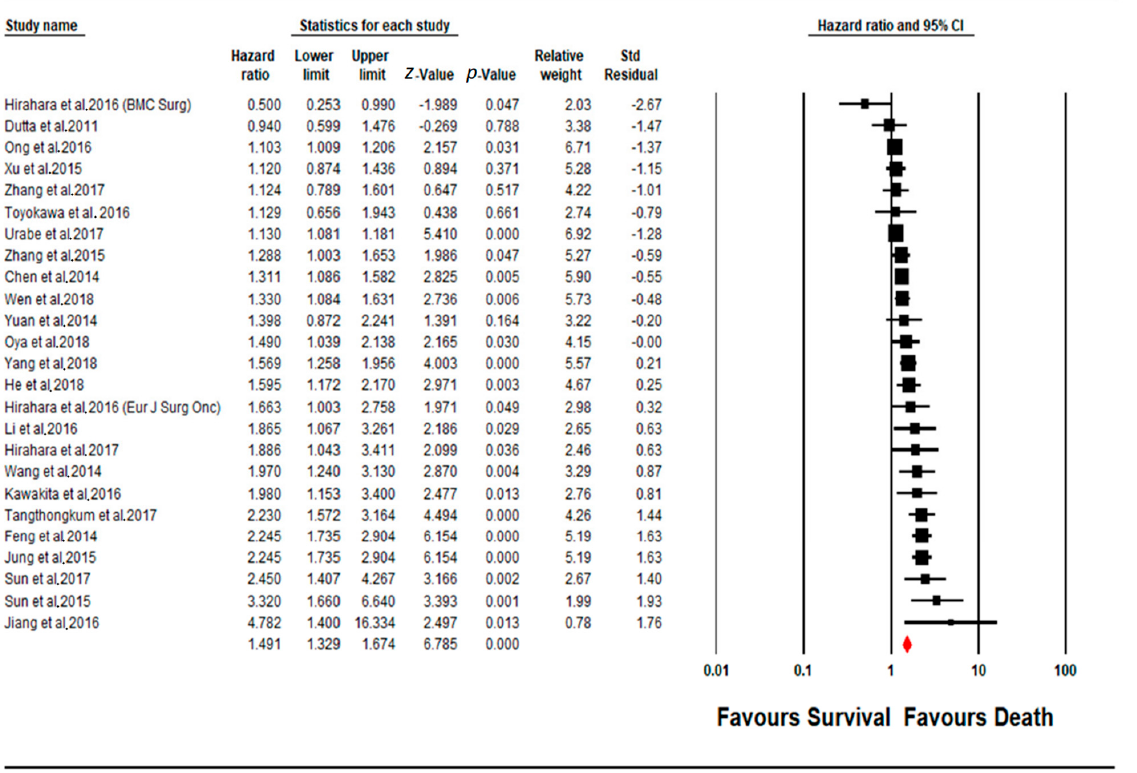
Figure 2. Forest plot of PLR subgroup.